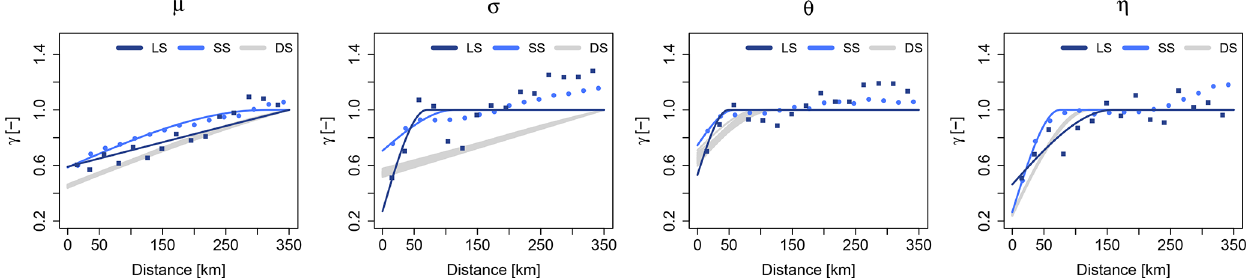
Figure 8. Empirical (dots) and fitted (solid lines) spherical theoretical variograms for the GEV ( µ – location and σ – scale) and Koutsoyiannis ( θ and η ) parameters estimated by three different datasets (long series LS in dark blue, short series SS in light blue and disaggregated daily series DS in grey).